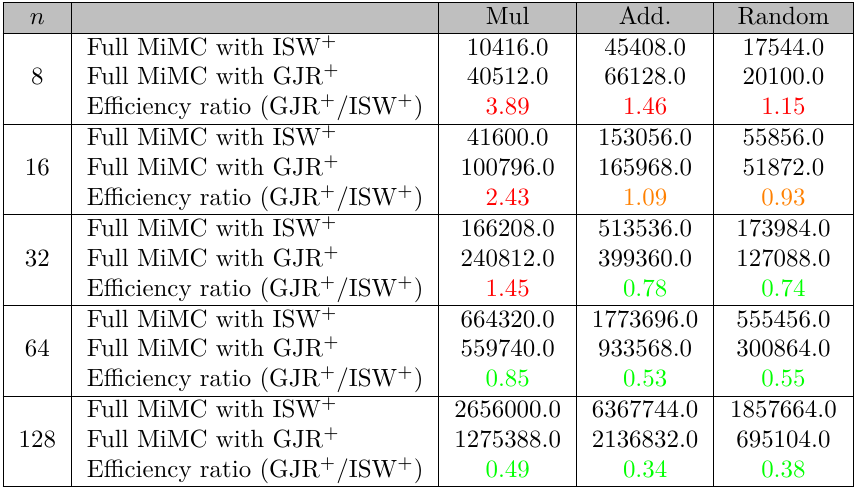
Table 6: Performances comparison for masked MiMC ( λ = 128).